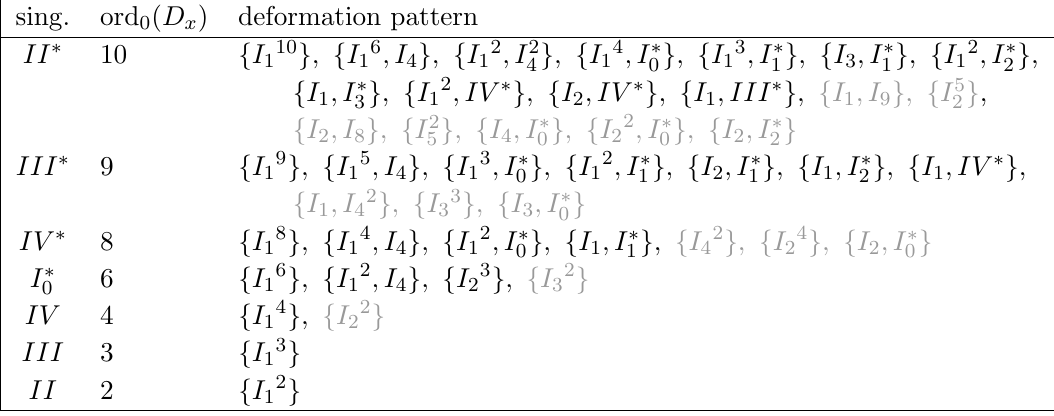
Table 4 . List of deformation patterns of Kodaira singularities allowed by the Dirac quantiza- tion condition. The ones in grey are incompatible with the SL(2 ; Z ) monodromies of the Kodaira